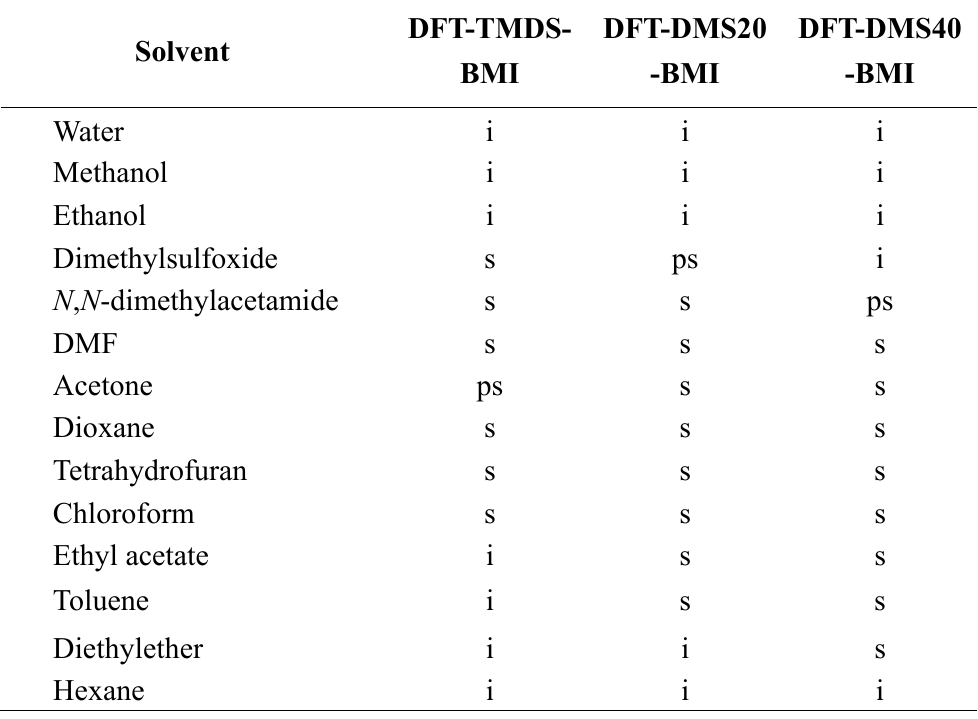
Table 2. Solubility of the polymers (i, insoluble; ps, partially soluble; s, soluble).